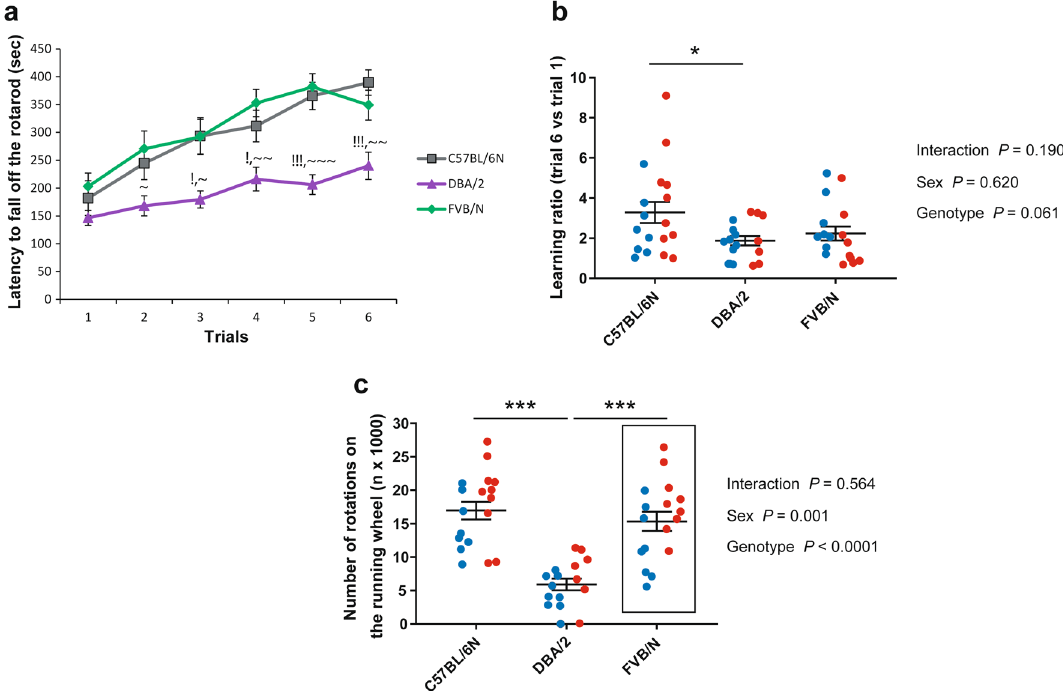
Figure 4. Motor activity in the P32–40 cohort of C57BL/6N, DBA/2, and FVB/N strains. ( a ) In the rotarod test, DBA/2 mice exhibited the lowest duration on the rotarod compared to C57BL/6N and FVB/N mice. For the detailed comparison between male and female mice within each strain, see Supplementary Fig. 3. ( b ) C57BL/6N mice showed a significant better learning ability in the rotarod test compared to DBA/2 mice. C) In the voluntary wheel running test, DBA/2 mice displayed the lowest number of rotations. Two-way ANOVA followed by Tukey post hoc test, ! p ≤ 0.05 and !!! p ≤ 0.001 for DBA/2 versus C57BL/6N; ~ p ≤ 0.05, ~~ p ≤ 0.01 and ~~~ p ≤ 0.001 for DBA/2 versus FVB/N; * p ≤ 0.05, *** p ≤ 0.001. A black rectangle indicates a significant difference between sexes within a strain (see Supplementary Table 2). Blue and red dots refer to males and females, respectively. Error bars indicate the standard error of the mean